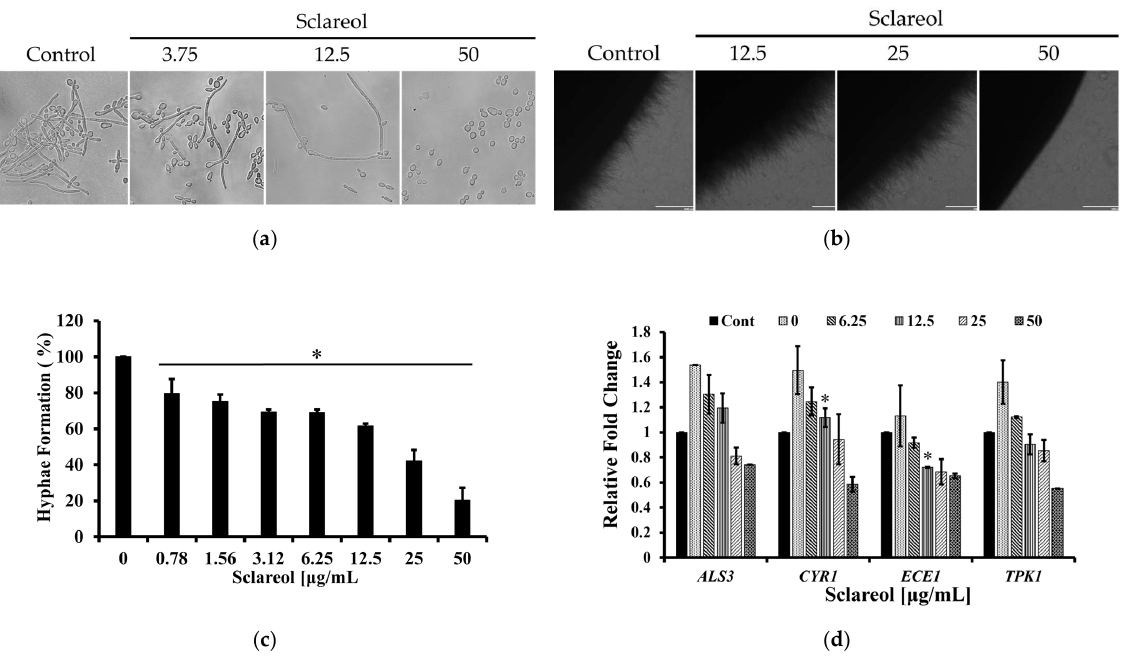
Figure 5. Sclareol inhibited the hyphal formation of C. albicans . ( a ) Sclareol inhibited the hyphal formation of C. albicans in broth media. C. albicans hyphae was formed in a medium supplemented with FBS with or without sclareol (3.75–50 µ g/mL) at 37 ◦ C for 24 h. ( b ) Sclareol inhibited the filamentation of C. albicans on spider medium. C. albicans cells were cultured on the spider media plates with sclareol for 7 days at 37 ◦ C. ( c ) Percentage of hyphal form of C. albicans in broth media. Data are presented as the mean ± SD of triplicate experiments. * p < 0.05 was considered significant. ( d ) Sclareol inhibited the expression of genes related with hyphal formation in C. albicans . Data are presented as mean values ± SD of triplicate experiments. * p < 0.05 was considered